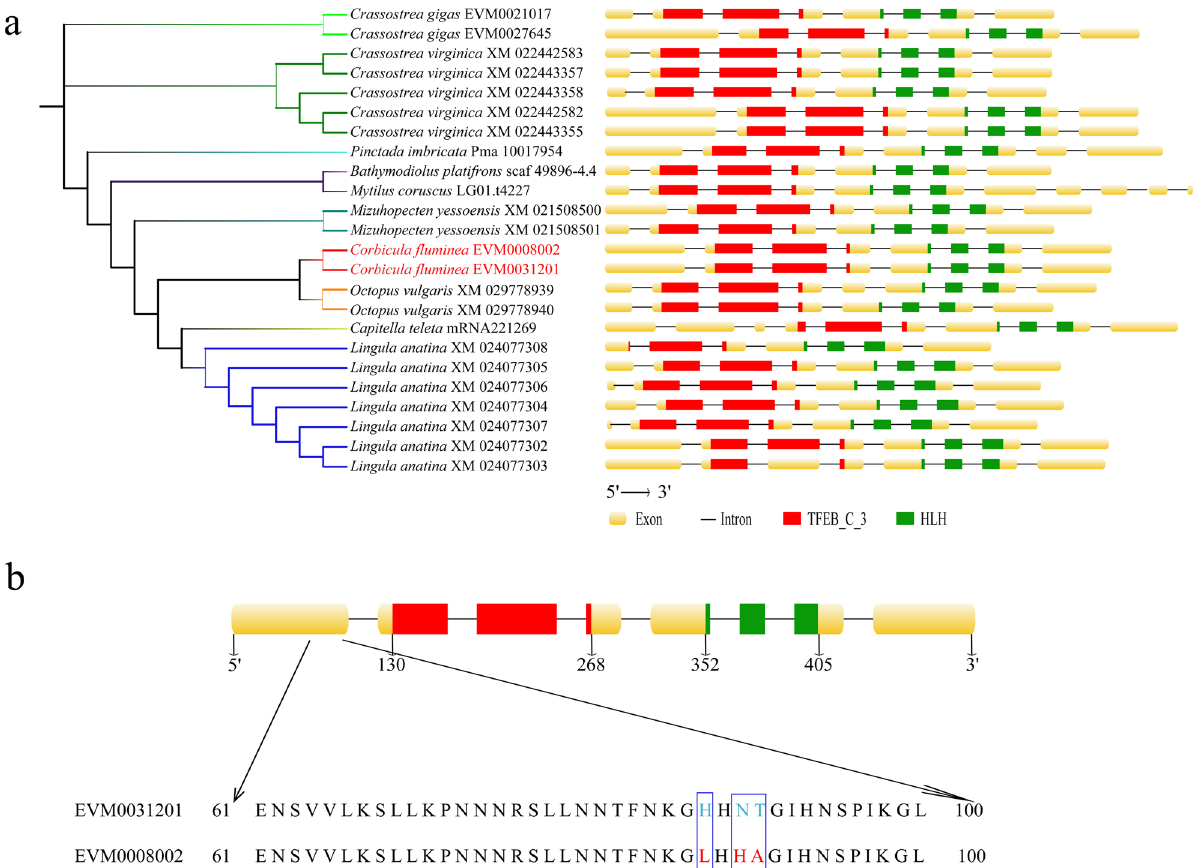
Figure 4. The analysis of MITF gene family. ( a ) The members of MITF family in Corbicula fluminea and other species. ( b ) The Commonalities and differences for MITF members in C.